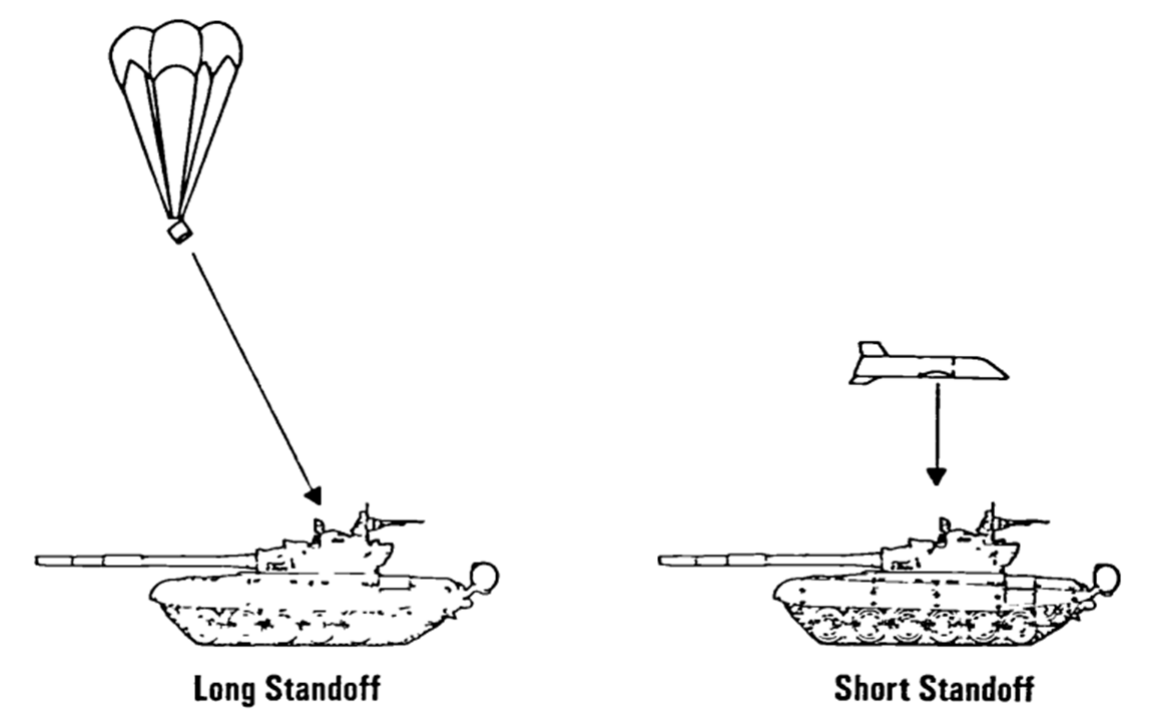
Figure 4. Two modern applications of EFP technology [5]